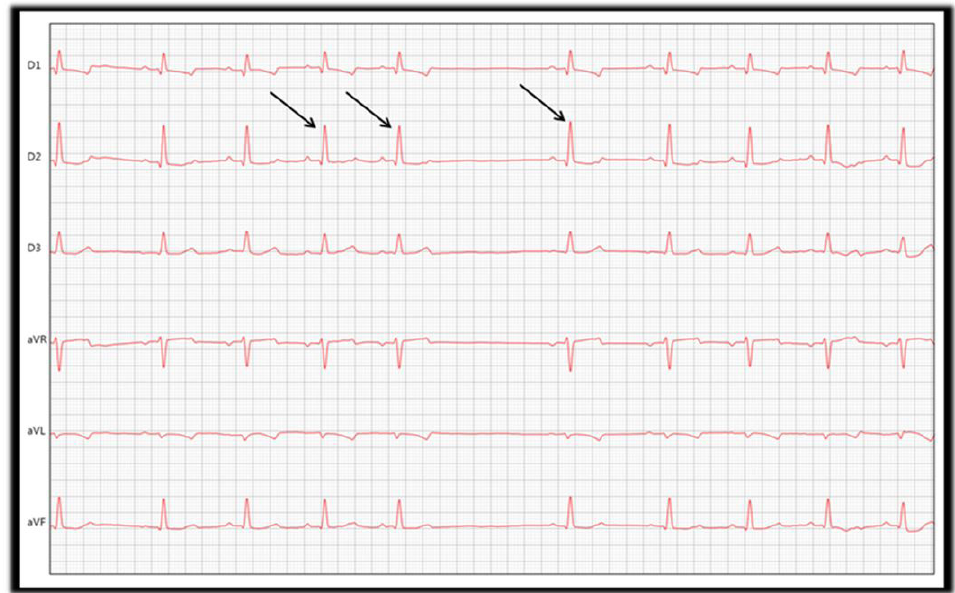
Figure 11. Electrocardiographic tracing at a speed of 50mm / s, showing tracing in bipolar leads, showing sinus arrest, represented by irregular R-R intervals (arrows), where the adjacent R-R interval is twice the length of the anterior interval. (Source: Personal